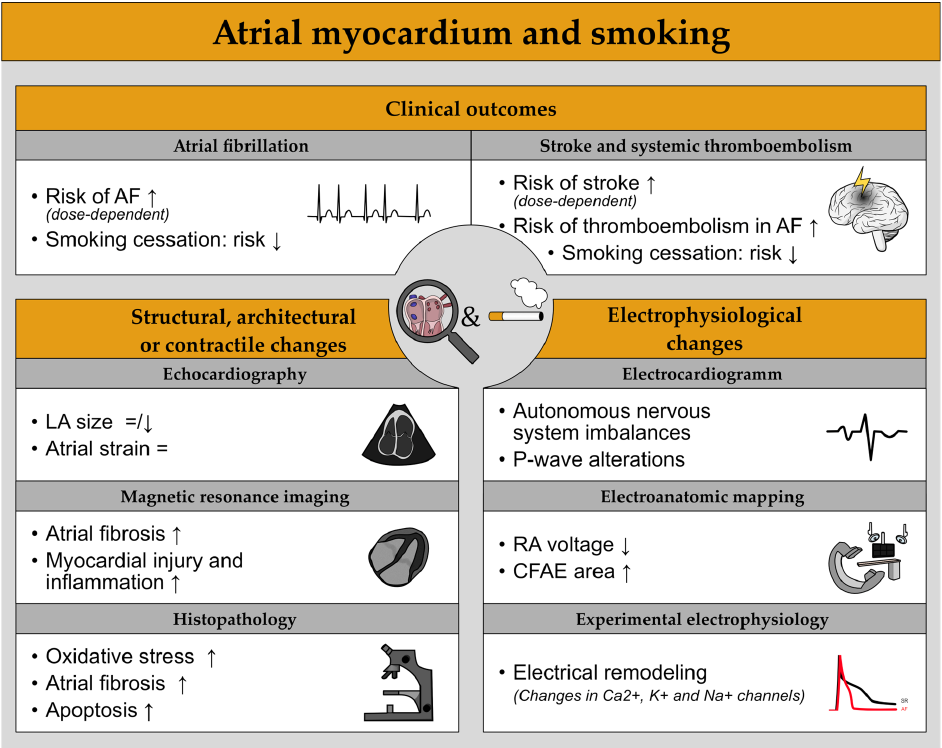
Figure 2. Overview of the impact of smoking on the atrial myocardium. = indicates no significant changes, ↑ an increase and ↓ a decrease of the respective